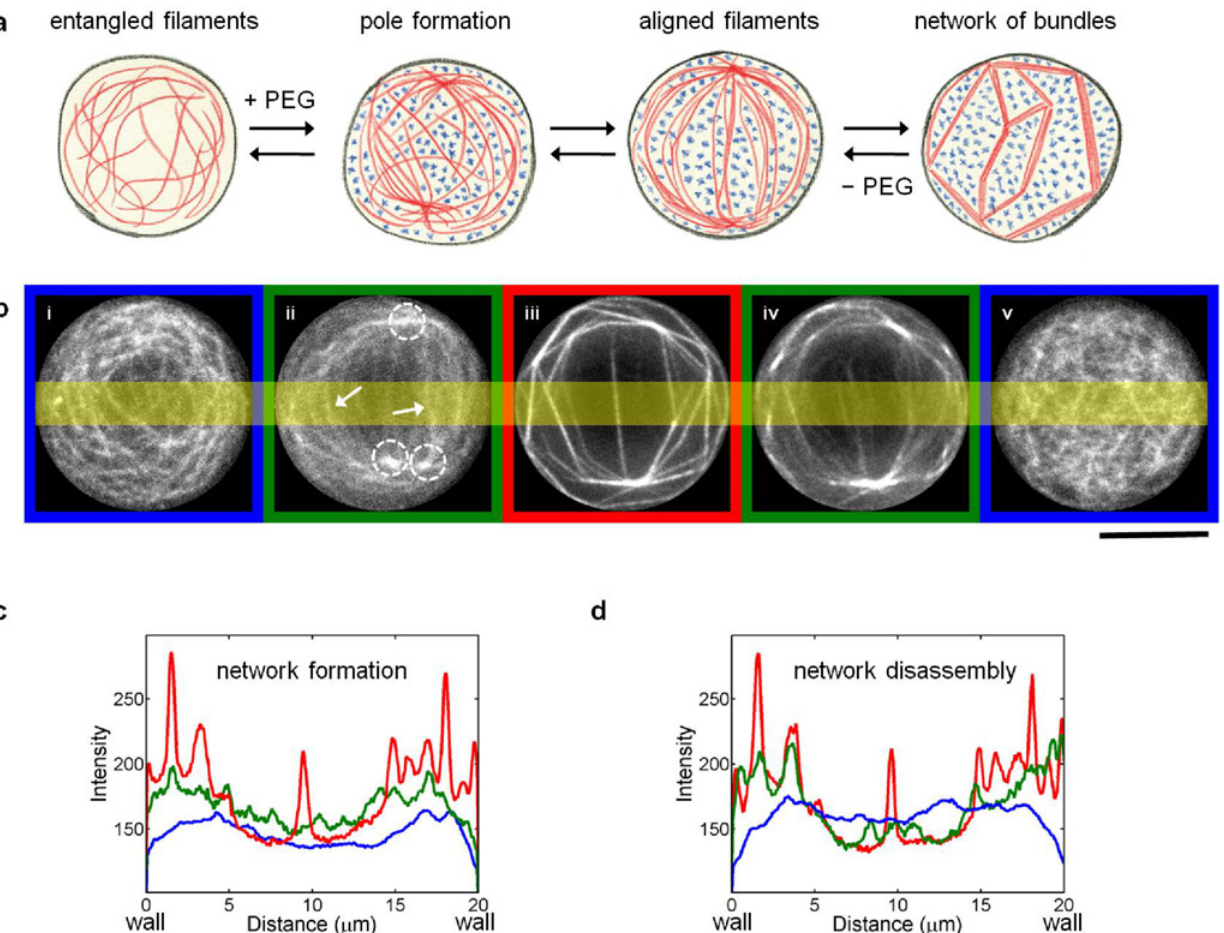
Fig 7. Spindle-like intermediate structure during the PEG-induced actin network formation. (a) Sketch of network formation by depletion interactions. (b) Time-lapse images showing the network formation induced by PEG polymers (5% w/v, M. W. 8000), and the subsequent disassembly after their depletion. The scale bar represents 10 μ m. (c, d) Mean intensity distribution through the highlighted area showing the spatial distribution of fluctuating filaments (blue), aligned filaments (green) and bundles (red) during (c) network formation and (d) disassembly.